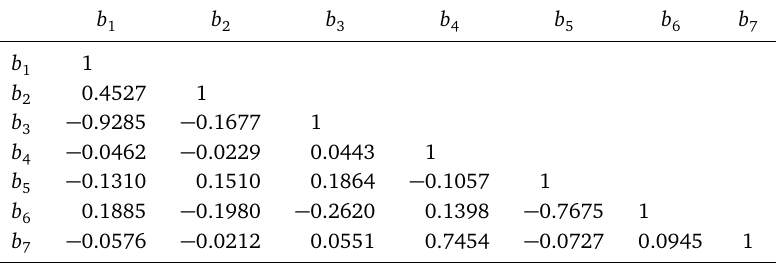
The correlation matrix of the